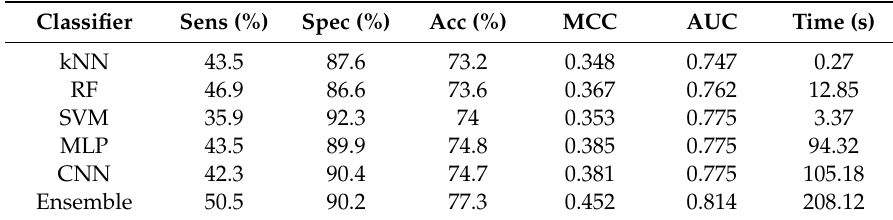
Table 2. Five-fold cross-validation performance in identifying essential genes using di ff erent machine learning, deep learning, and ensemble learning techniques. MCC: Matthews correlation coe ffi cient.